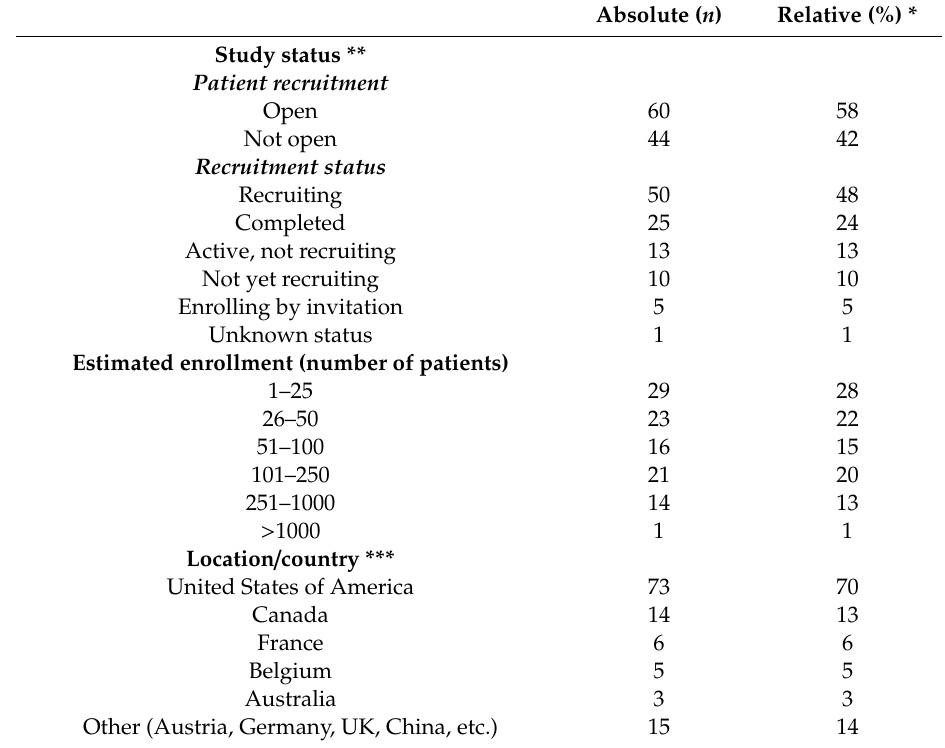
Table 2. Recruitment parameters of the included clinical prospective prostate cancer-related trials with PSMA-radioligands from the ClinicalTrials.gov registry ( n =